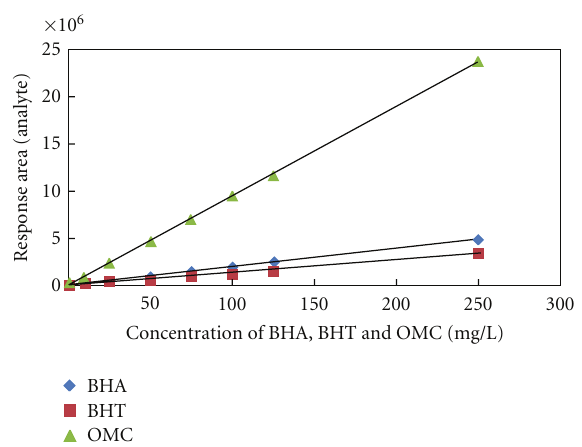
Figure 5: Calibration curves for BH, BHT, and OMC analysed on RP-HPLC-UV/Vis at λ max = 280nm, 0.8 mL/min and (water: acetic acid, 99:1, v/v) as mobile phase.